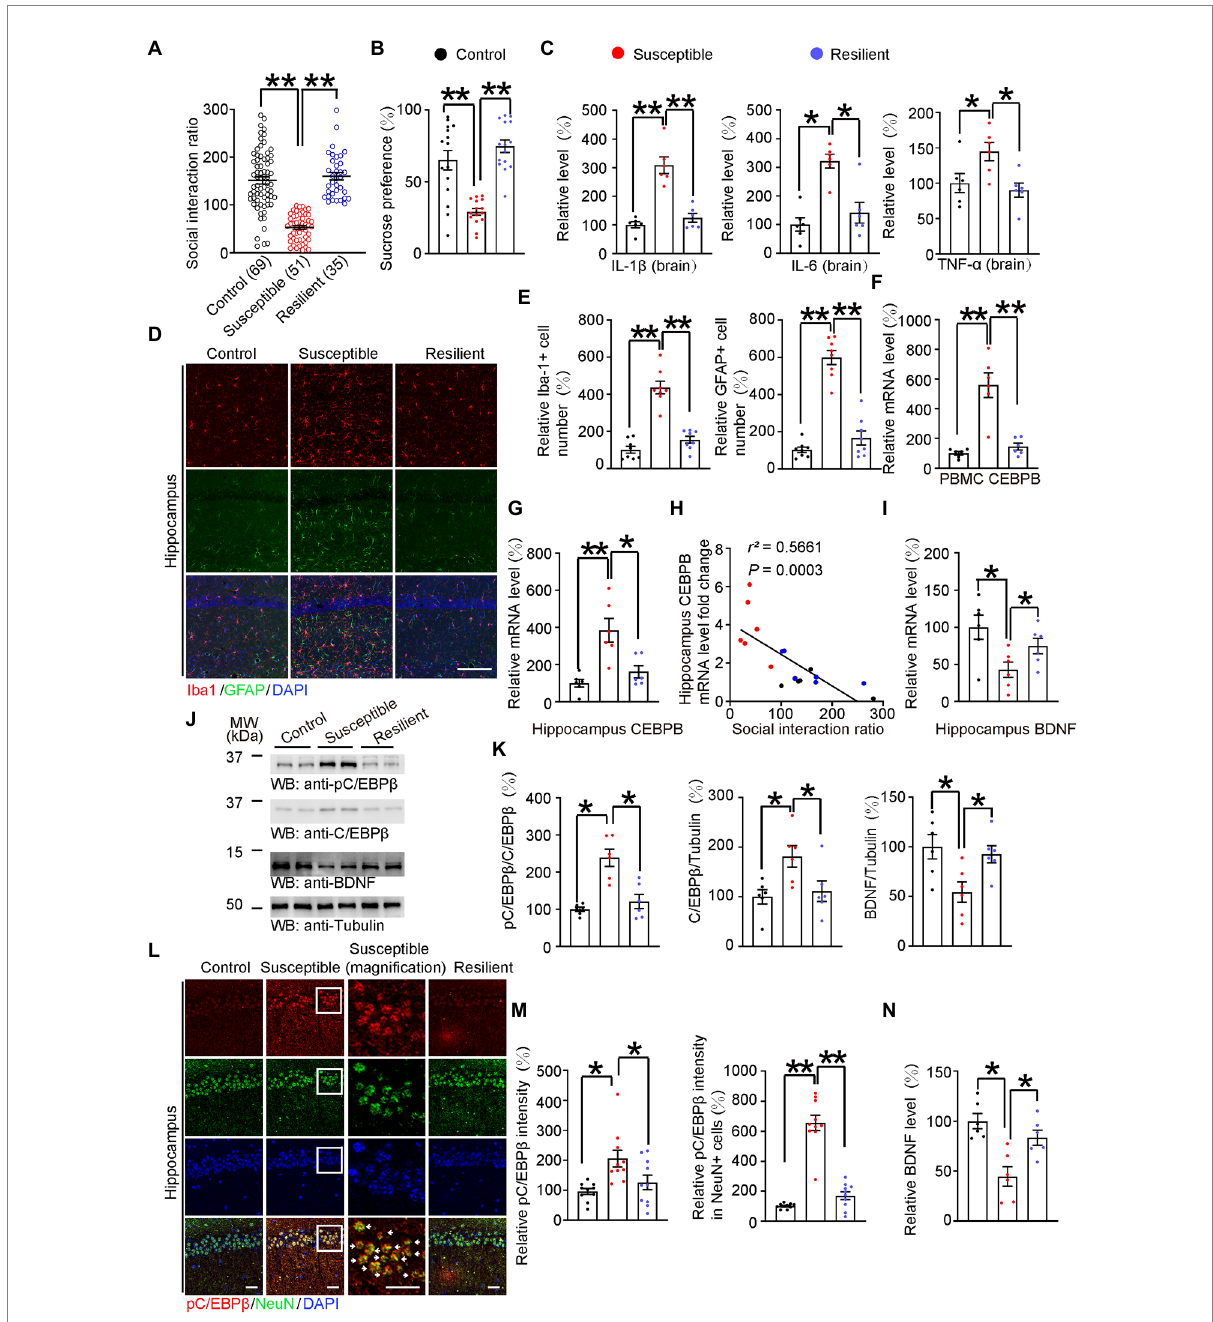
FIGURE 2 HFD-induced neuroinflammation activated C/EBP β and further downregulated BDNF in anhedonic mice. (A) Scatter plot depicting the distribution of interaction ratios for control (fed with chow diet), susceptible (fed with HFD for 12 weeks), and resilient (fed with HFD for 12 weeks) mice after subthreshold social defeat stress. Data are presented as mean ± SEM ( n = 69 mice for the control group, n = 51 mice for the susceptible group, n = 35 mice for the resilient group, ** p < 0.01, one-way ANOVA and Bonferroni’s multiple comparison test). (B) Sucrose preference test. Data are represented as mean ± SEM ( n = 15 mice for each group, * p < 0.05, * p < 0.01, one-way ANOVA and Bonferroni’s multiple comparison test). (C) ELISA quantification of neuroinflammation factors IL-1 β , IL-6, and TNF α in the brain lysates from the above mice. Data represent mean ± SEM of six samples per group from three independent experiments (* p < 0.05, ** p < 0.01, one-way ANOVA and Bonferroni’s multiple comparison test). (D) Immunofluorescent co-staining of Iba-1 and GFAP on the hippocampal sections of the above mice. Scale bar: 150 μ m. (E) Quantification of Iba-1+ and GFAP+ cells was analyzed (E) n = 8 for each group, ** p < 0.01, one-way ANOVA and Bonferroni’s multiple comparison test). (F) CEBPB mRNA level in the PBMCs after subthreshold social defeat stress. Data represent mean ± SEM of six samples per group (* p < 0.05, * p < 0.01, one-way ANOVA and Bonferroni’s multiple comparison test). (G) CEBPB mRNA level in the hippocampus after subthreshold social defeat stress. Data represent mean ± SEM of six samples per group ( ∗ p < 0.05, ∗∗ p < 0.01, one-way ANOVA and Bonferroni’s multiple comparison test). (H) Correlation between the hippocampal CEBPB mRNA levels and the social interaction ratio after subthreshold social defeat stress. Quantitative analysis of the